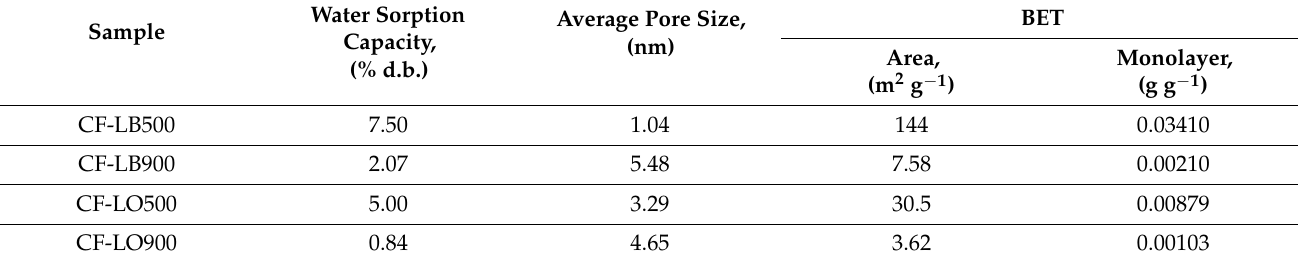
Figure 3. Particle size distribution of ferrite-lignin hybrids. Table 2. DVS parameters of lignin